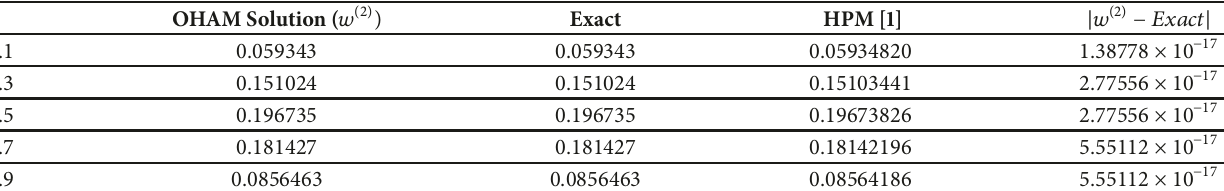
Table 1: Comparison of the third-order OHAM solution with the exact solution and HPM.